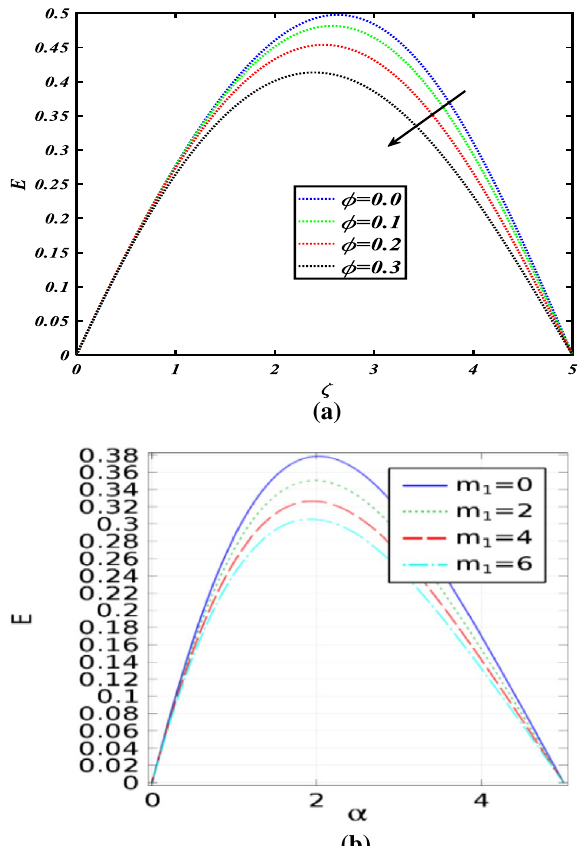
Figure 9. (a) Radial velocity under the influence of nano-particle concentration profile, ( b ) results obtained by 40 for radial velocity under the varying concentration of